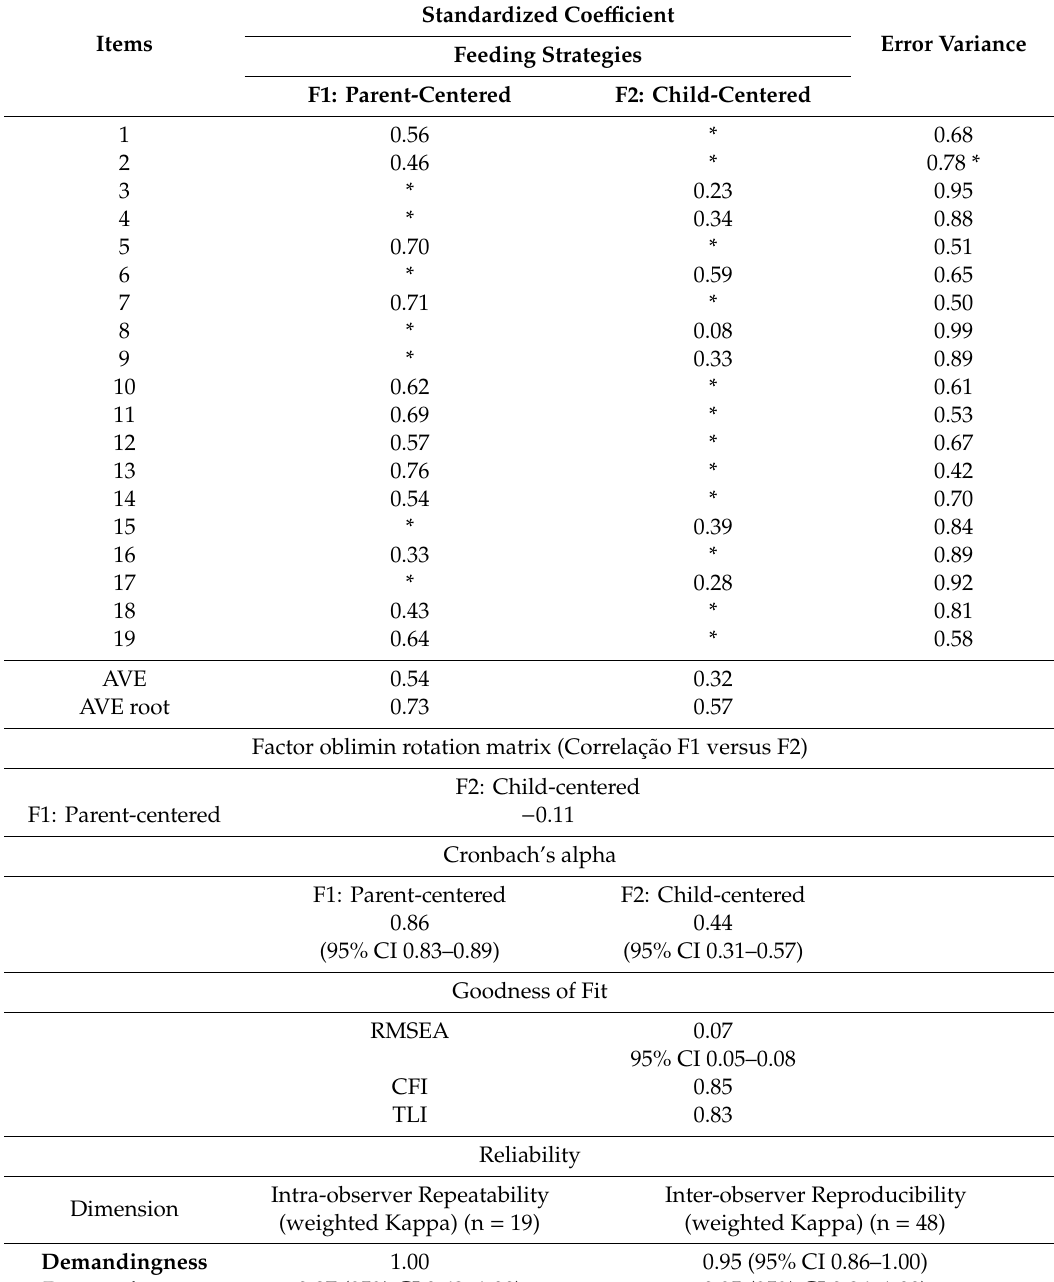
Table 3. Standardized coe ffi cient of the 19 items (Factors 1 and 2) by structural equation model, error variance, Cronbach’s alpha, and reliability by weighted Kappa of the Brazilian (Rio de Janeiro) of the two-dimensional prototype of the CFSQ, Rio de Janeiro, Brazil,